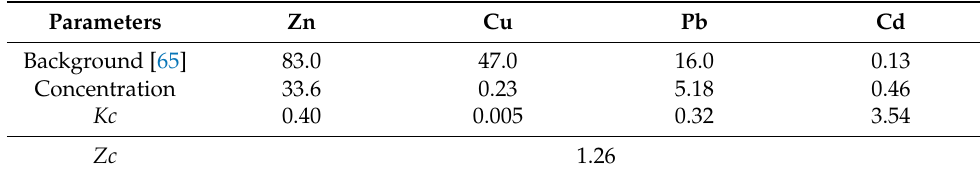
Table 3. Calculation of the pollution level of the bottom